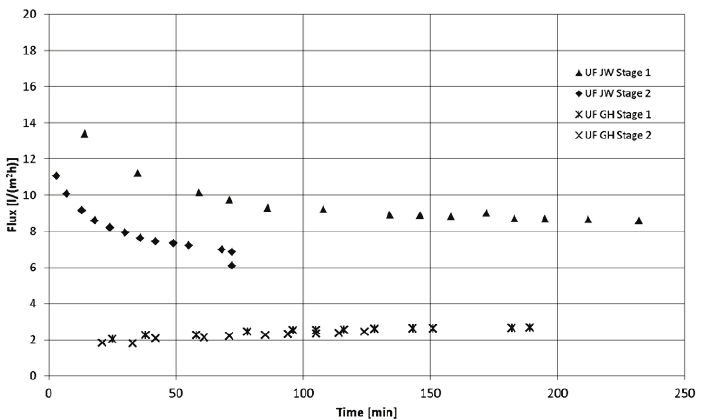
Figure 5. Permeate fluxes of ultrafiltration pre-treatment.